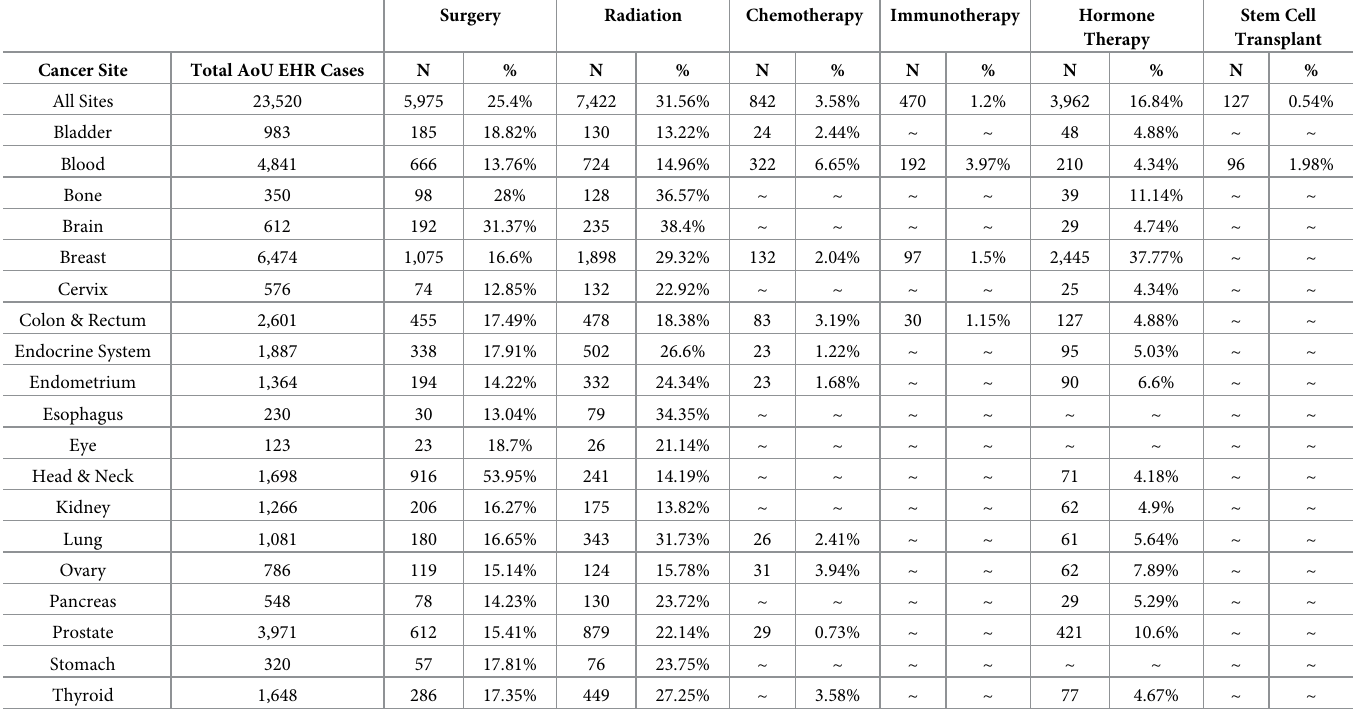
Table 6. Cancer treatment type overall and by site in the All of Us Research